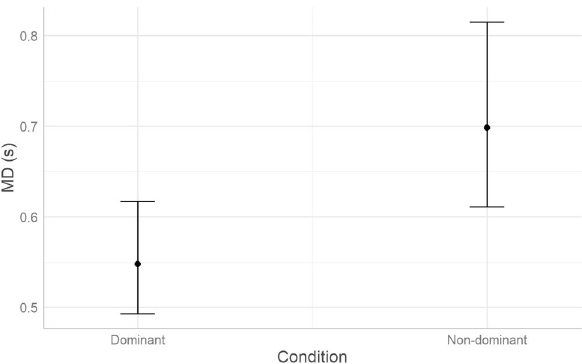
Figure 4. Predicted effects of Condition on MD (n trials = 6011, n ADHD = 17, n TD = 26, MD is expressed in seconds, estimated marginal means with whiskers representing 95% confidence